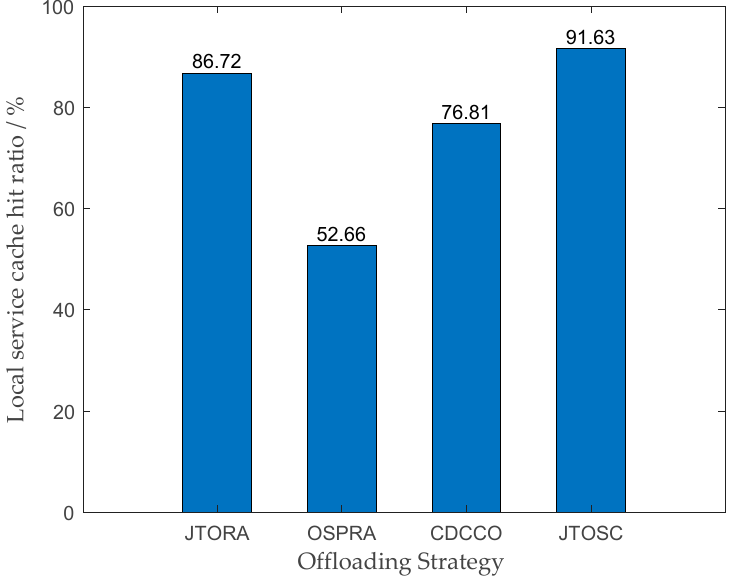
Figure 7. Comparison of the local service cache hit ratio under different strategies.